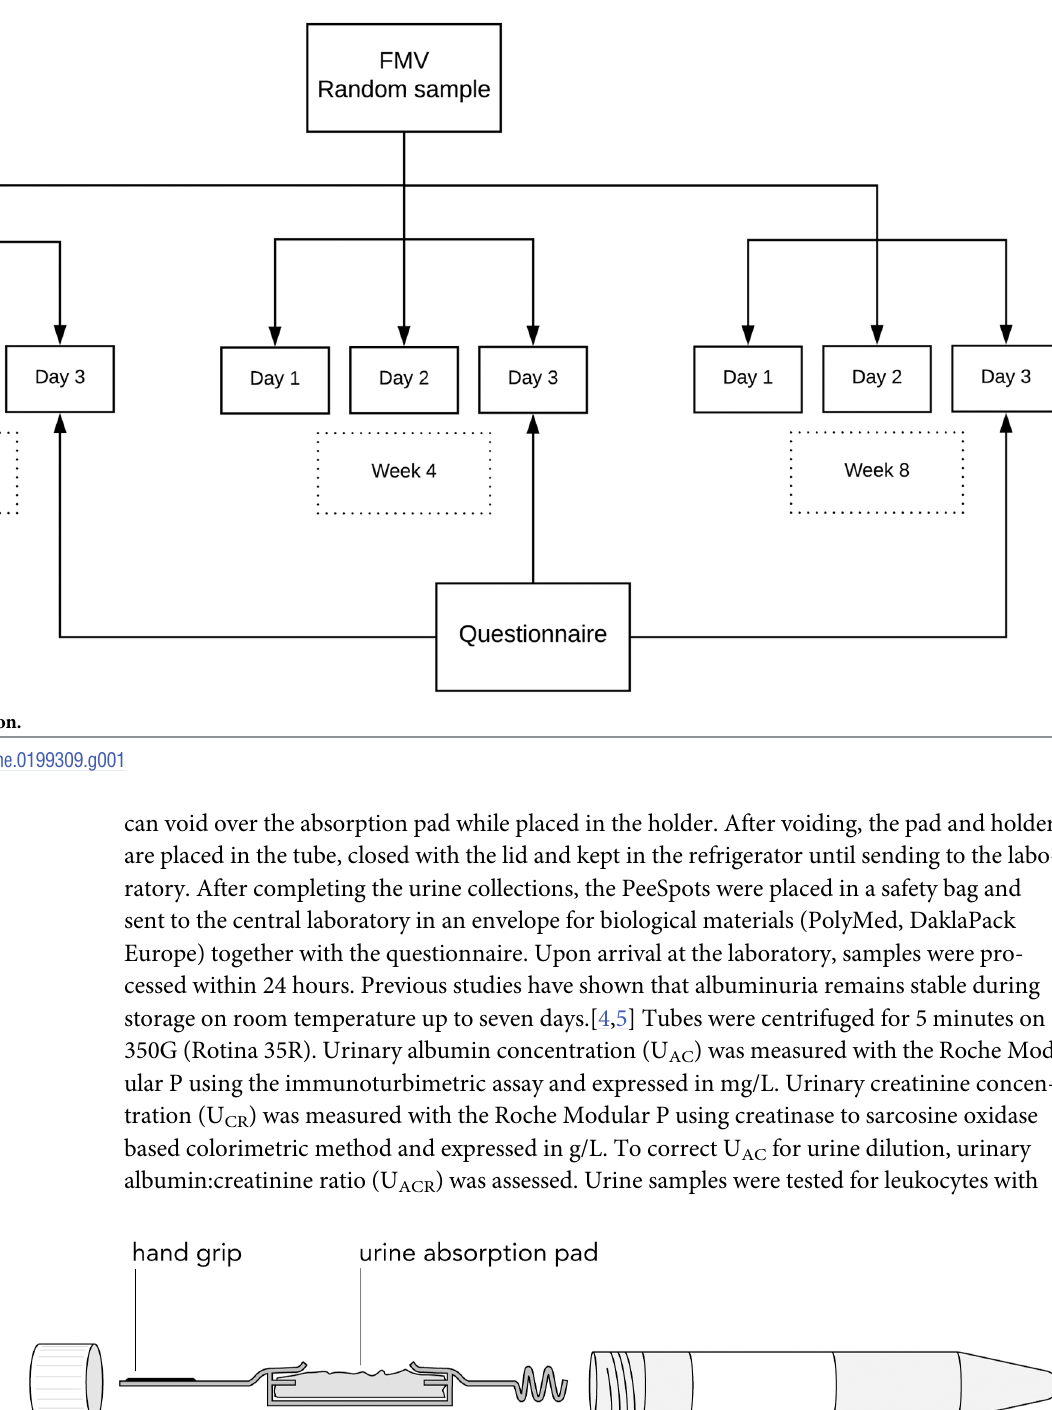
Fig 2. The PeeSpot